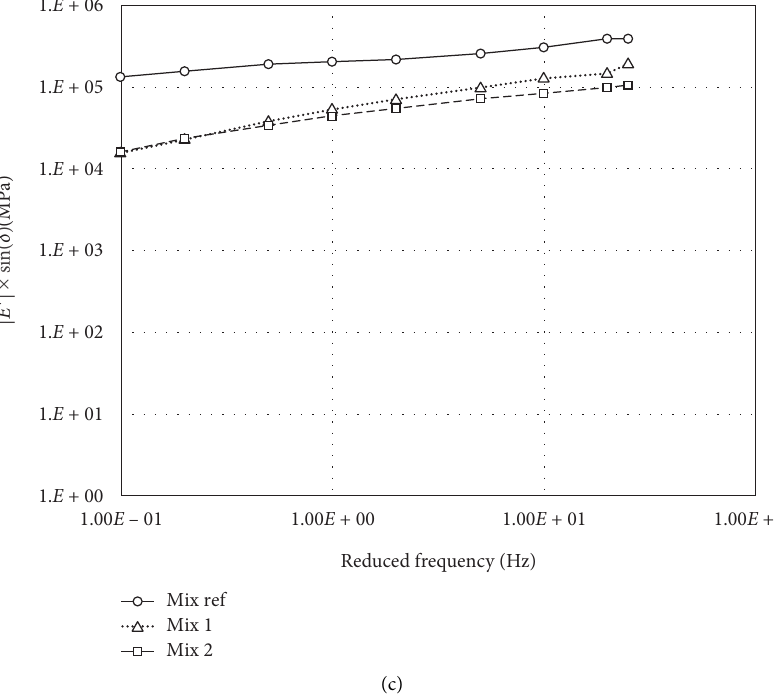
Figure 9: Fatigue parameters at (a) 5 ° C, (b) 20 ° C, and (c) 31 °